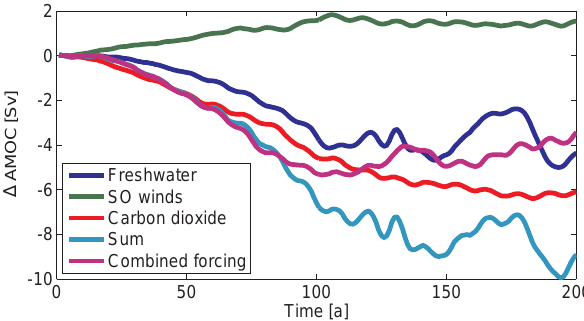
Fig. 13. AMOC changes for individual forcings and for combined forcing.